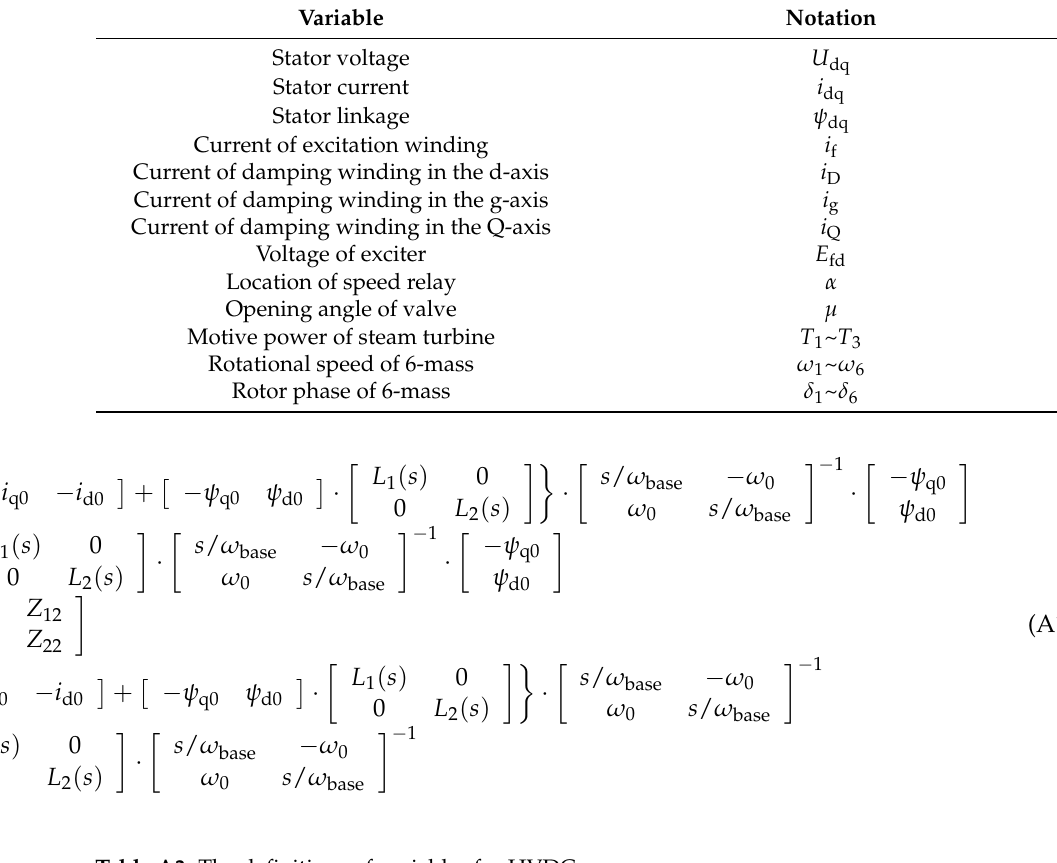
Table A2. The definitions of variables for the SG.